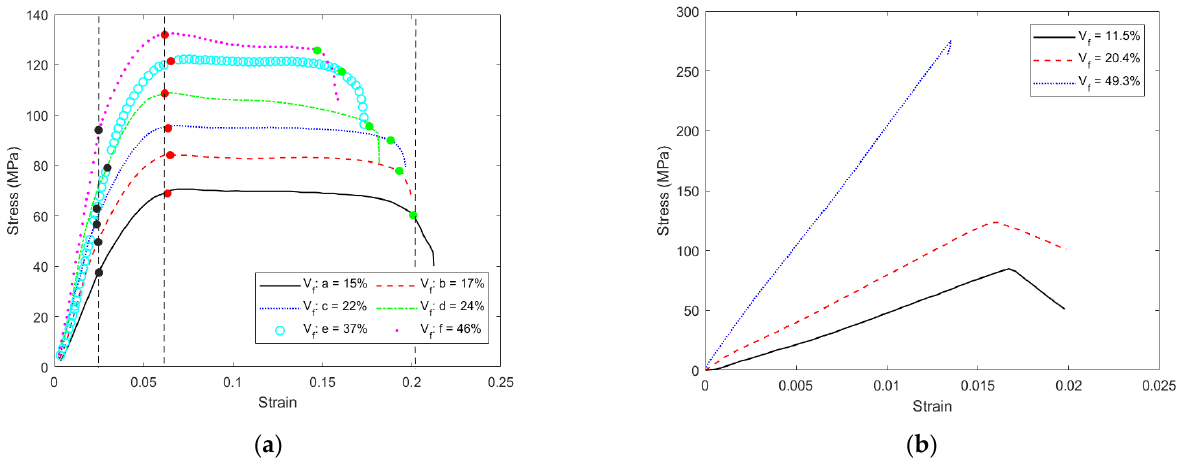
Figure 1. ( a ) Compressive stress-strain responses of bamboo with varying Vf [40]; ( b ) Tensile stress- strain response of bamboo with varying Vf [41]. strain response of bamboo with varying Vf